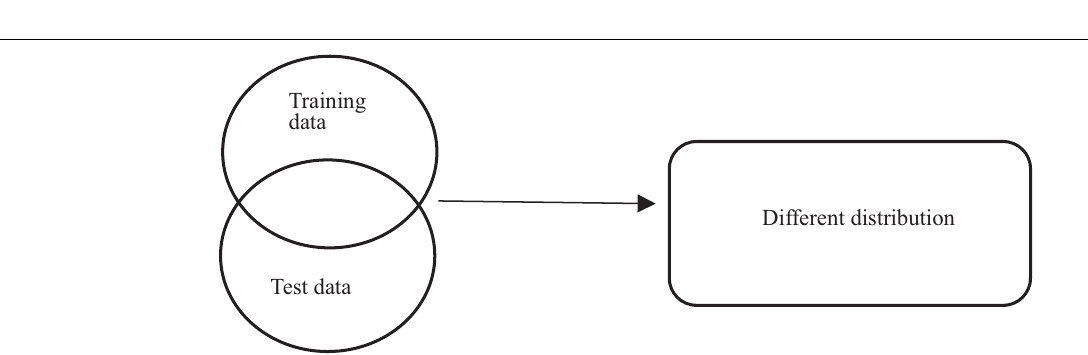
FIGURE 1 | Data distribution scenarios required by traditional methods.